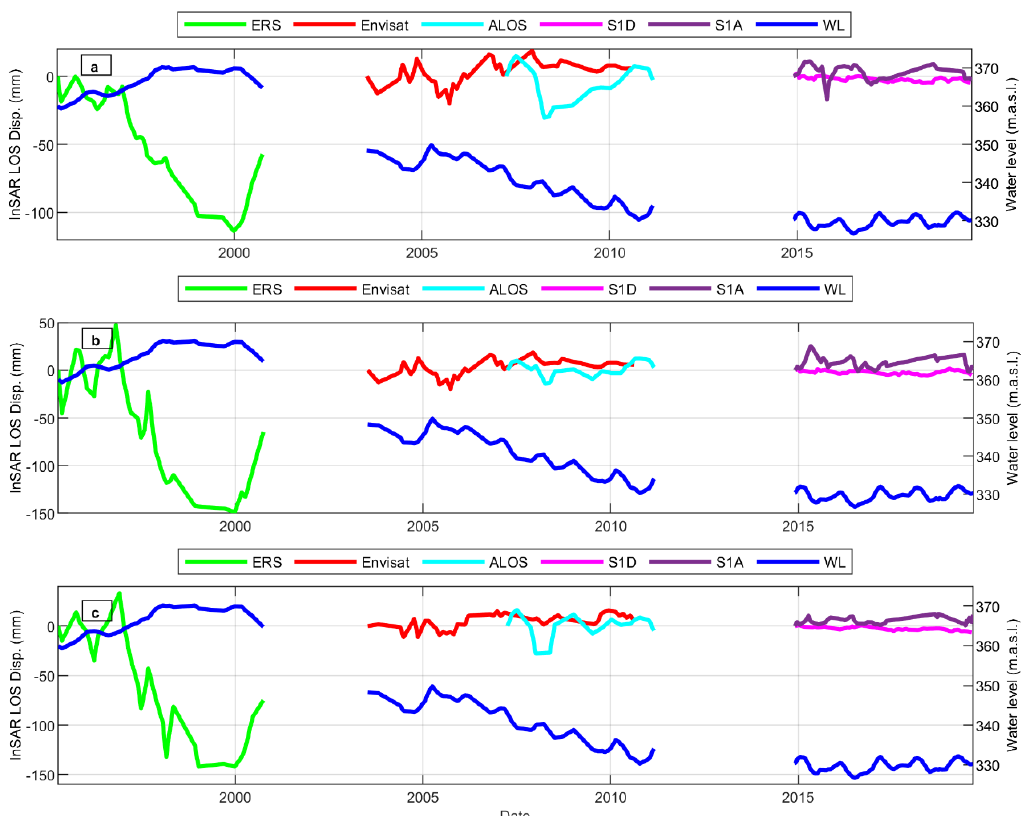
Figure 5. Water level and InSAR − calculated displacement relative to the initial ground level of each sensor-period. Water level (m.a.s.l, dark blue) and InSAR LOS average displacement of a 3 × 3 pixel−area at 500 m from the shore and along the transects ( a ) A, ( b ) B, and ( c ) C.